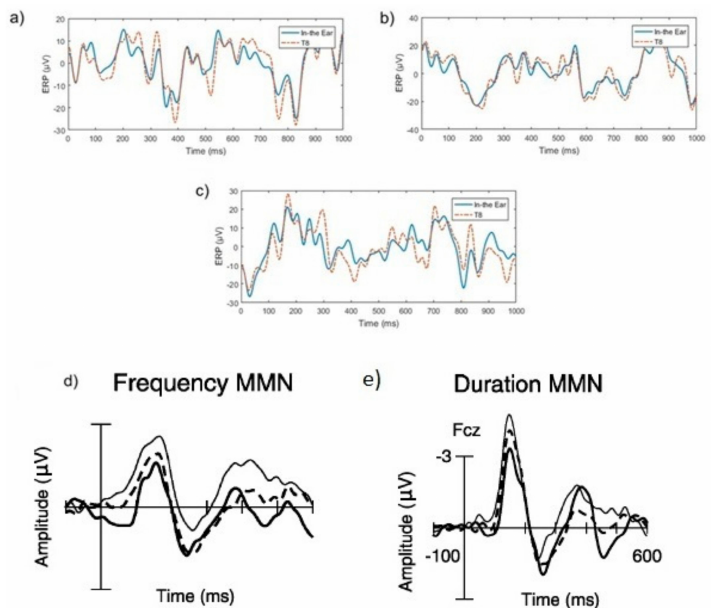
Figure 6. Examples of EEG after mismatch trials. ( a ) Example of frequency mismatch EEG event-related potential (ERP) response. ( b ) An example of duration mismatched EEG ERP response. ( c ) An example of an EEG ERP response after a standard beep. The blue and red lines in ( a – c ) show the in-ear and T8 EEG signal, respectively. ( d , e ) Duration and frequency mismatch responses from [40] for comparison. The dotted line in ( d , e ) show the ERP responses from similar traditional mismatch negativity (MMN) experiments to our work. The thin and thick lines in ( d , e ) show the MMN responses for specially designed experiments from [40].